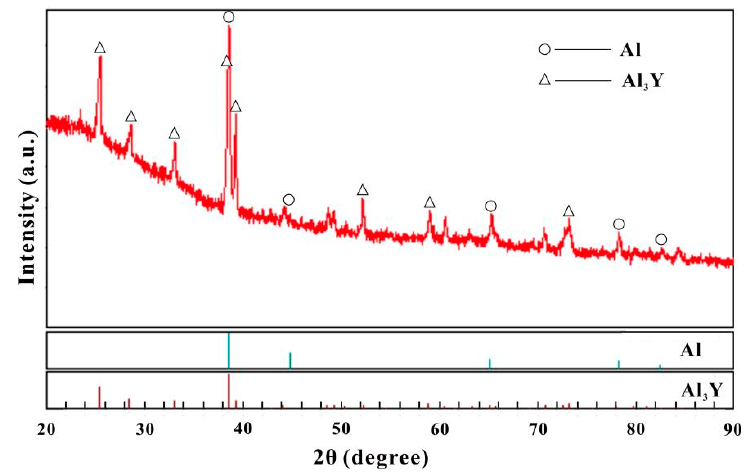
Figure 7. XRD pattern of alloy sample No. 15.